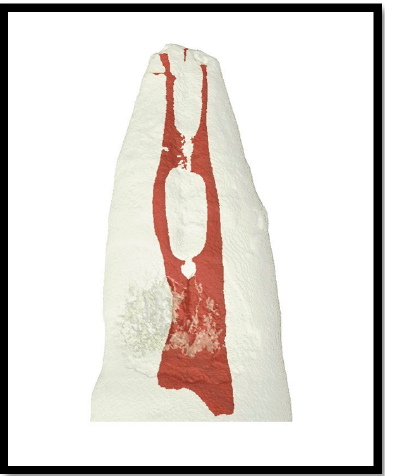
Figure 7. Micro-CT image showing Vertucci’s type VII (1-2-1-2) canal configuration.